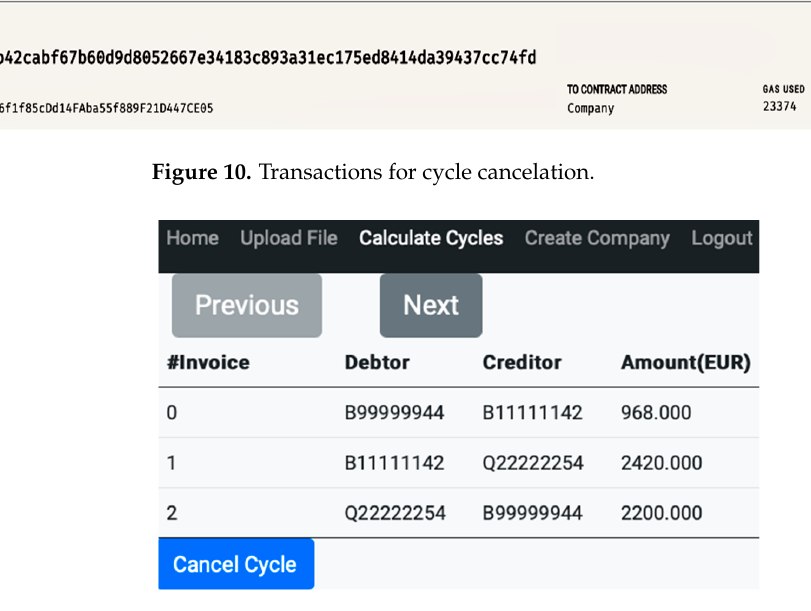
Figure 11. Cycle cancelation example.